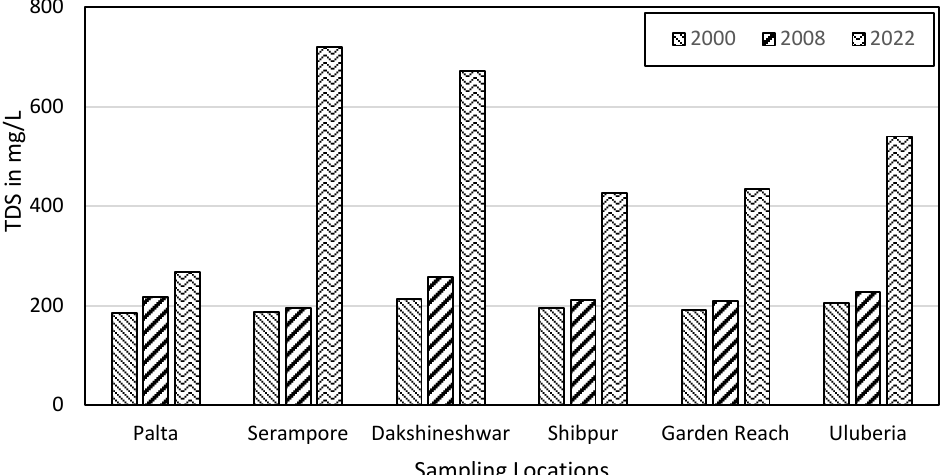
Figure 9. Variation of TDS in different locations.